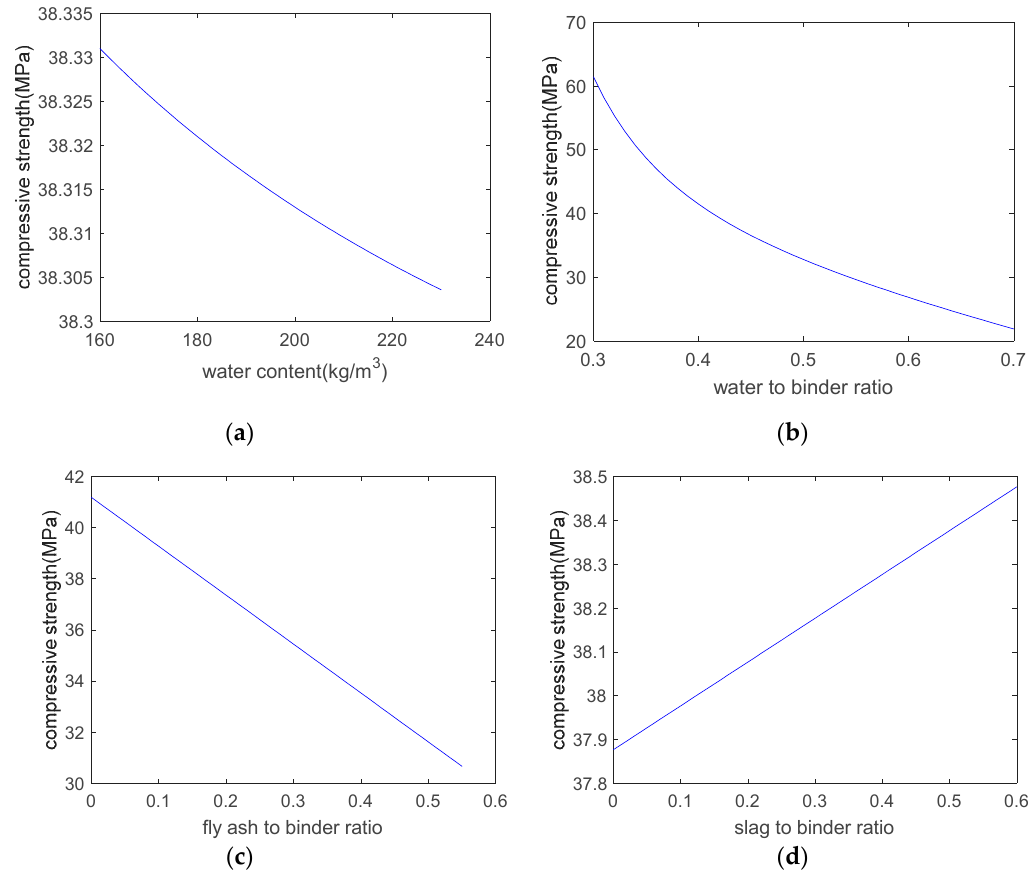
Figure 3. Parameter analysis of strength. ( a ) effect of water content on strength; ( b ) effect of water–to–binder ratio on strength; ( c ) effect of fly–ash–to–binder ratio on strength; ( d ) effect of slag–to–binder ratio on strength.